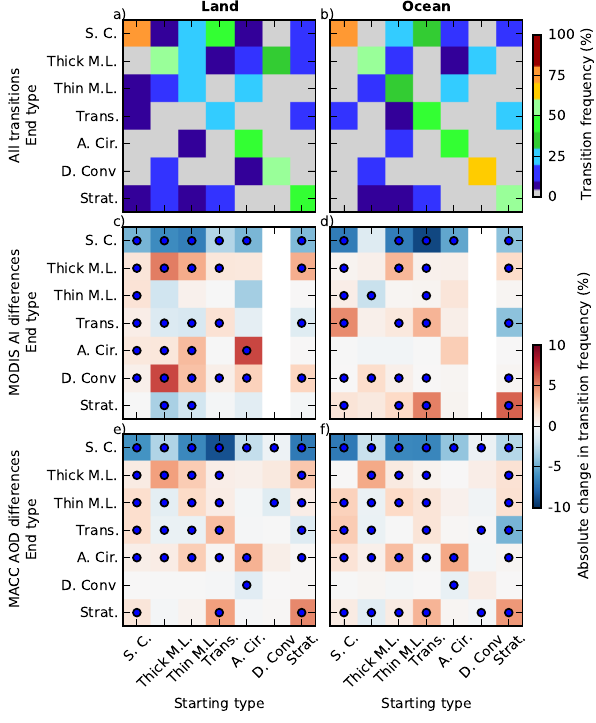
Fig. 3. Regime transition histogram showing the conditional prob- ability of a given transitions between regimes over (a) land and (b) ocean during the 3h period between 1030 and 1330LST, given each starting regime. Each column sums to 100%. The difference in the histograms between the highest and lowest MODIS AI quartile days over (c) land and (d) ocean, and using MACC AOD over (e) land and (f) ocean. Positive values indicate an increase in the frequency of the transition with increasing AI. Note the non-linear colourbar in (a) and (b) . The dots indicate 95% statistical significance. This plot covers regime transitions for the tropical region (30 ◦ N–30 ◦